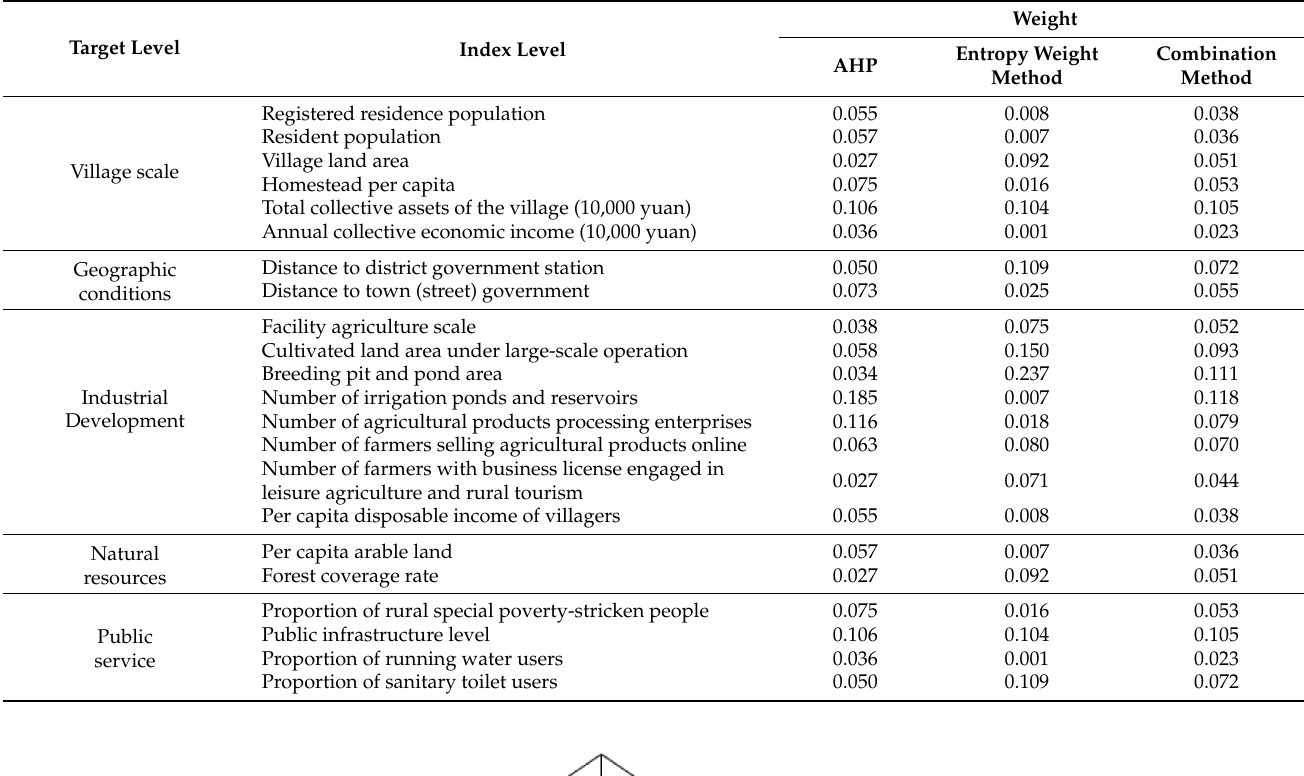
Table 3. Weight of development level classification indicators.